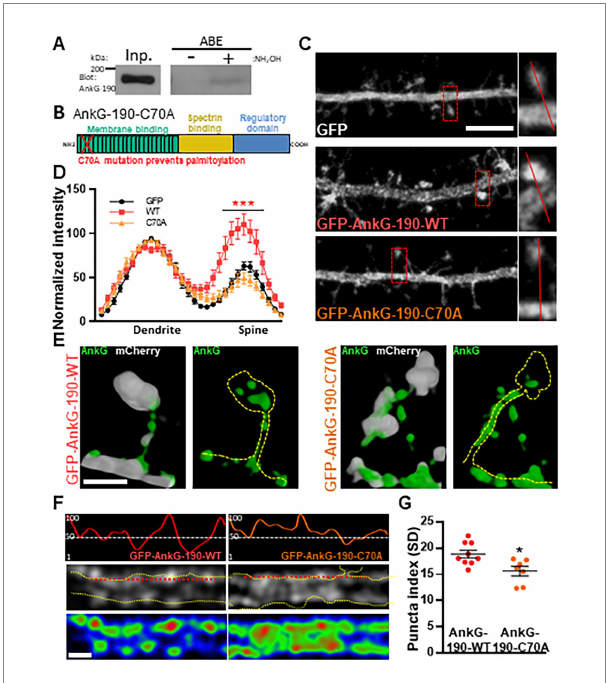
FIGURE 1 Palmitoylation of cysteine 70 stabilizes AnkG-190 in dendritic spines and dendrites. (A) AnkG-190 is palmitoylated in rat forebrain. Solubilized rat forebrain homogenates were subjected to ABE to purify palmitoylated proteins. ABE fractions and a portion of input homogenate (Inp.) were western blotted to detect AnkG. Exclusion of NH 2 OH was used as a control for assay specificity. (B) Schematic of 190 kDa Ankyrin-G isoform showing the mutated cysteine which prevents palmitoylation. (C) Confocal images of 24-day cultured cortical neurons expressing mCherry with GFP, GFP-AnkG-190-WT, or GFP-AnkG-190-C70A for 1 day, scale = 5 μ m. (D) Linescan analysis of spine:dendrite ratio of expressed GFP, GFP-AnkG-190-WT, or GFP-AnkG-190-C70A (16–20 neurons per condition, 2-way ANOVA with Dunnett’s post-test, *** p < 0.001, ±SEM). (E) Spine SIM imaging 3D reconstruction of cultured rat neurons expressing mCherry (white), GFP-AnkG-190-WT, or GFP-AnkG-190-C70A (both green), scale = 0.5 μ m. (F) SIM imaging of dendrites from cultured cortical neurons expressing GFP-AnkG-190 or GFP-AnkG-190-C70A, scale = 0.5 μ m, in gray or pseudocolor (middle and bottom) and their associated normalized linescan (top). (G) Scatter plot of the puncta index average (7–9 neurons per condition, Mann Whitney, * p < 0.05, ±SEM) for GFP-AnkG-190-WT or GFP-AnkG-190-C70A